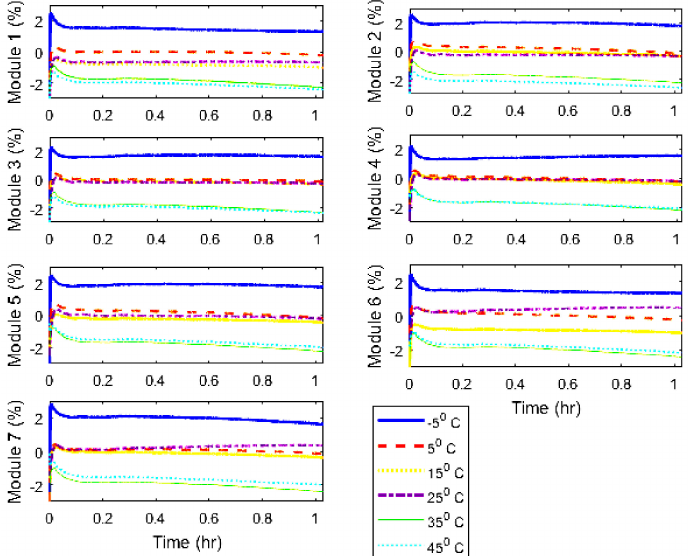
Figure 15. The SoC estimation of cell modules with respect to the temperatures: − 5, 5, 15, 25, 35 and 45 ◦ C. The calculation time of the SoC estimation algorithm in this test is 0.002 s, corresponding to a sample time of T s = 1